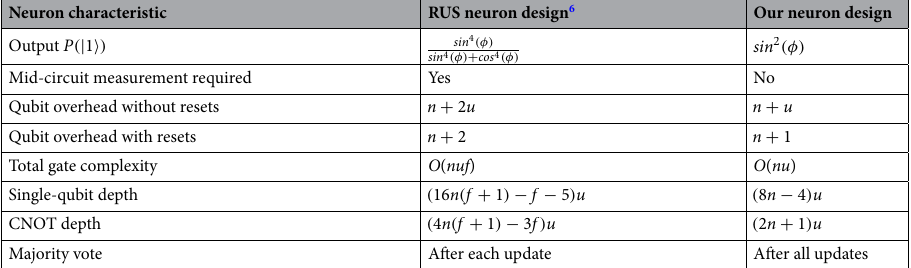
Table 1. A summary of the differences between our quantum neuron and the quantum neuron designed by Cao et al. 6 . In these calculations, it is assumed that reset is unavailable and there is no recursion in the Cao et al. neuron. The parameter n represents the size of the associative memory, u represents the number of updates, and f represents the average number of failures in the RUS process. See the Supplementary Information for a more detailed analysis and derivation of gate